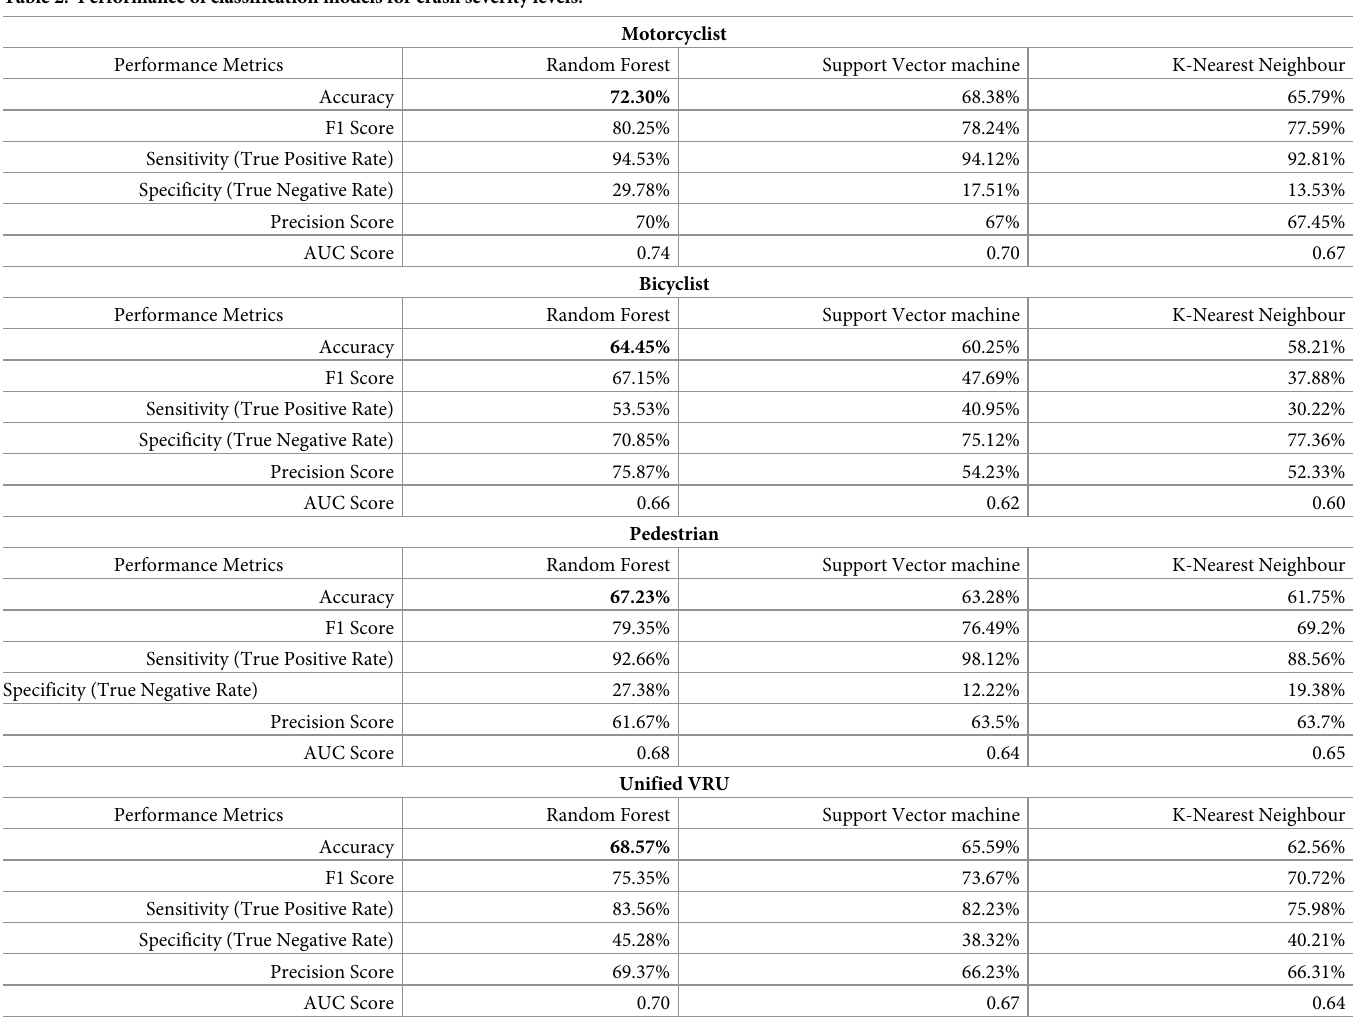
Table 2. Performance of classification models for crash severity